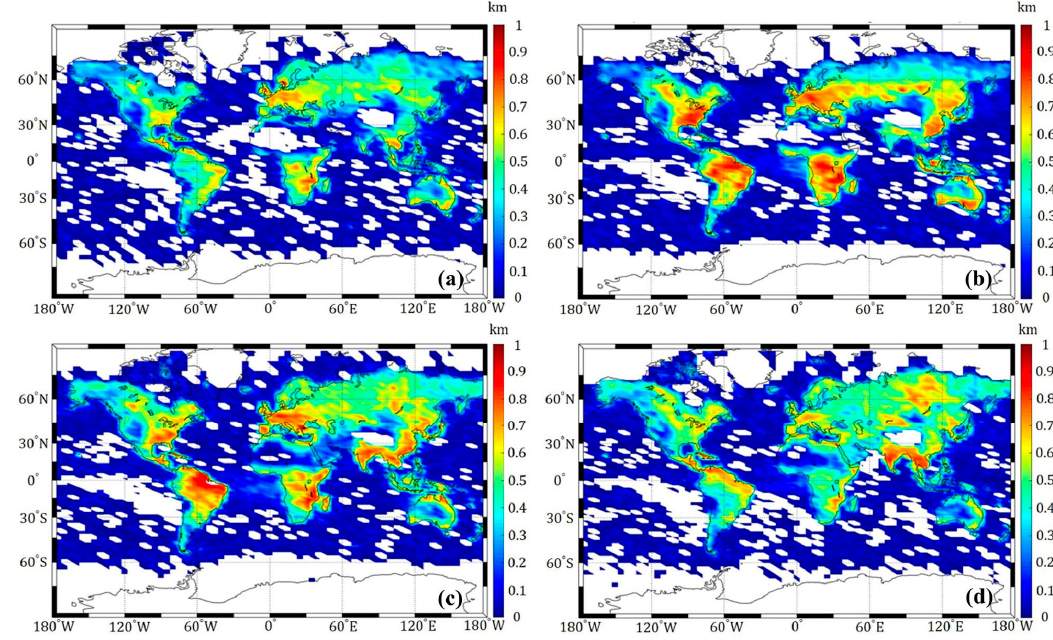
Figure 7. Same as Figure 5 but for the smoke aerosol MFASD.